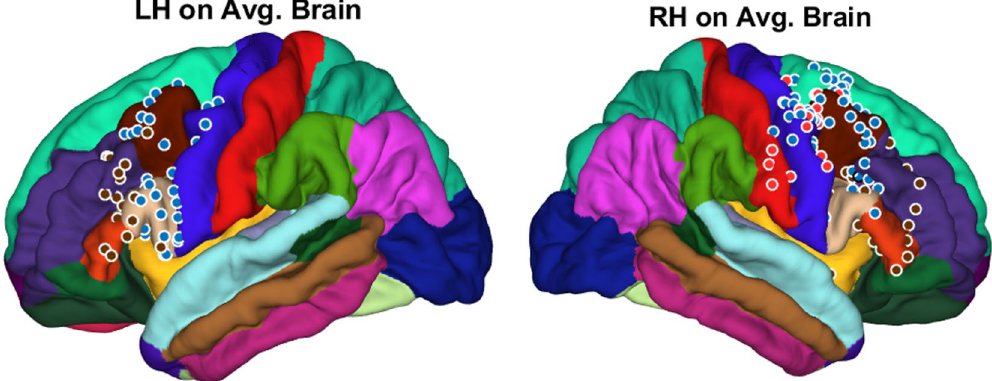
Figure 5 . Location of permanent grid electrodes on average brain model. 1st group (blue dots): subjects 1–6 with permanent grid implantation over both premotor and motor cortex; 2nd group (brown dots): subjects 7–8 with permanent grid implanted over premotor cortex; 3rd group (red dots): subject 9 whom permanent grid implanted over sensory, motor, and premotor